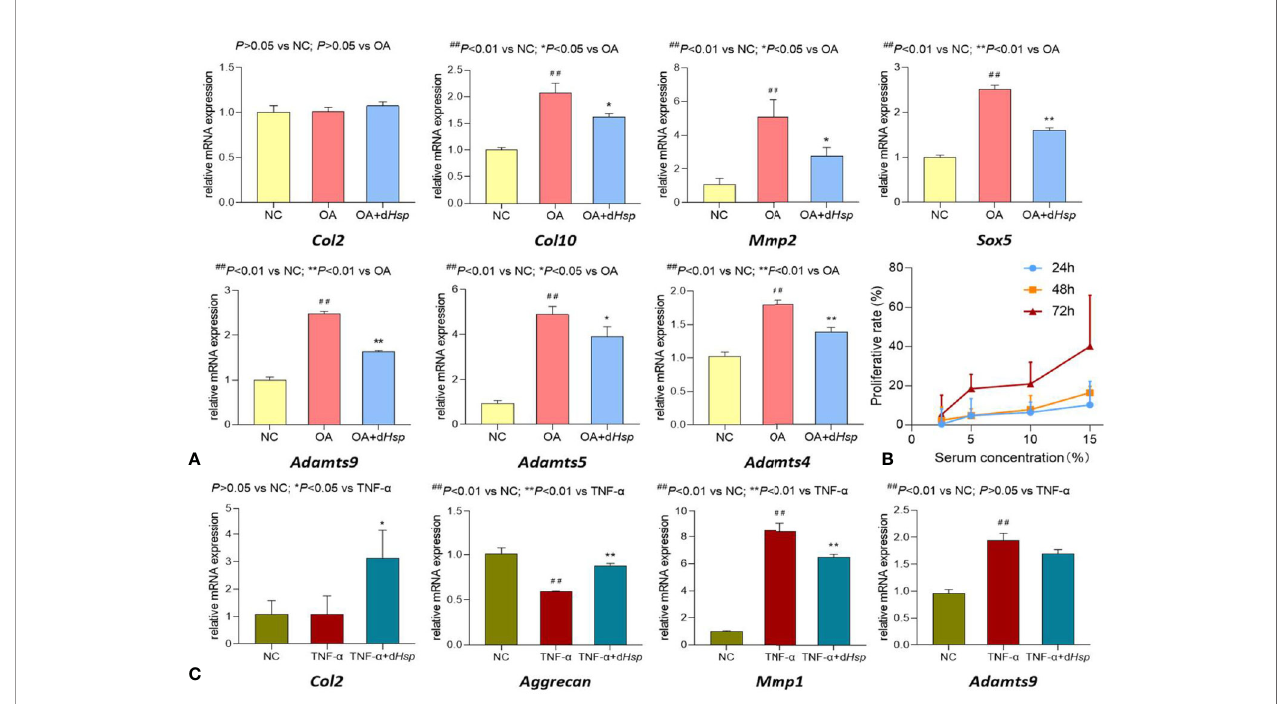
FIGURE 5 | (A) Relative mRNA expressions of OA-related genes in cartilage tissue after oral administration of saline (NC group), saline (OA group), and 14 g/kg d Hsp (OA+ d Hsp group). (B) Cell viability of chondrocytes treated with d Hsp- containing serum for 24, 48, and 72 h. (C) Relative mRNA expressions of target genes in chondrocytes treated with TNF- a or TNF- a plus d Hsp- containing serum for 24 h. Values are presented as mean ± SD. ## P<0.01 vs. NC group; *P<0.05 or **P<0.01 vs. TNF- a